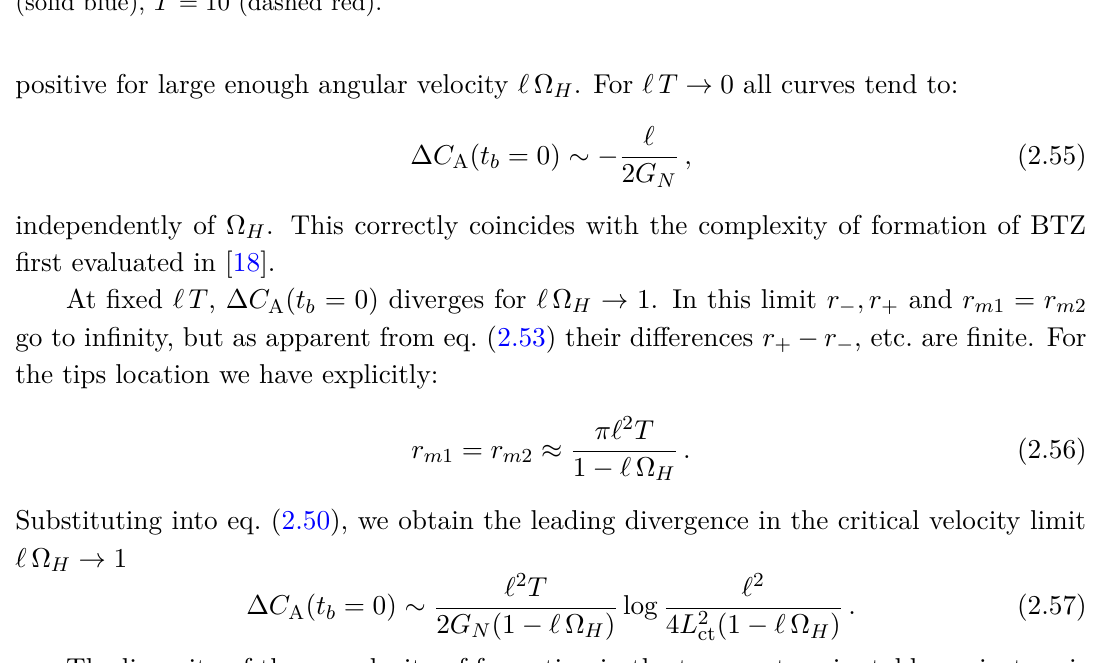
Figure 6 . Above: time dependence of (left) π dC A and (right) π ∆ C A for ‘ = G N = T = 1 and dt b Ω H = 0 . 1 (dotted magenta), Ω H = 0 . 5 (solid olive), Ω H = 0 . 9 (dashed green). Below: complexity of formation π ∆ C A ( t b = 0) for ‘ = G N = 1 and (left) Ω H = 0 . 1 (dotted magenta), Ω H = 0 . 5 (solid olive), Ω H = 0 . 9 (dashed green), (right) T = 0 . 1 (dotted gray), T = 1 (solid blue), T = 10 (dashed